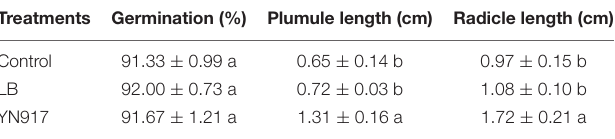
TABLE 1 | Rice seed growth-promoting effects of Bacillus cereus